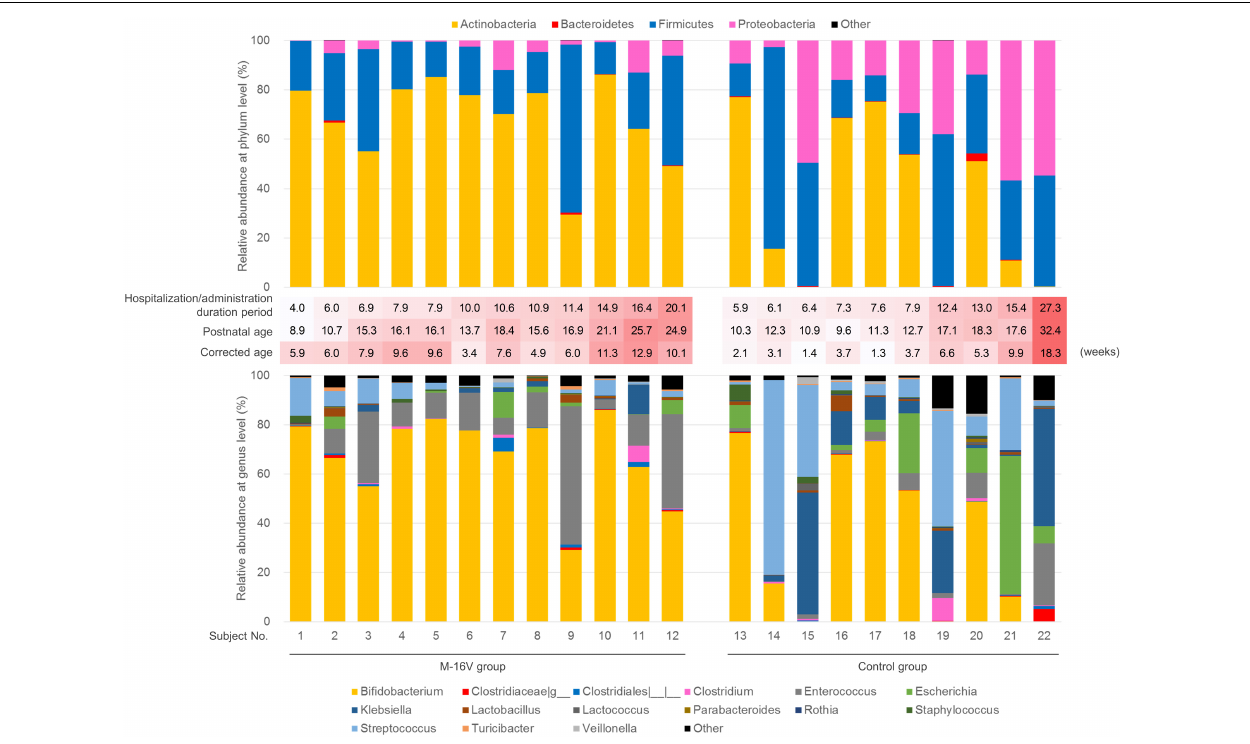
FIGURE 3 | Fecal microbiota composition of each subject. Relative abundance of each phylum (upper) and genus (lower) of microbiota of each subject. The four phyla and 15 genera indicated in Table 2 were shown. In the middle of the figures, hospitalization period (that is, probiotic administration duration in the M-16V group), postnatal and corrected age at the fecal sampling scaled by red color were indicated. The darker the red color, the higher the value of administration duration/hospitalization period, postnatal age, and corrected age, respectively. Subject No. 1–12 were in the M-16V group, and subject No. 13–22 were in the control group.